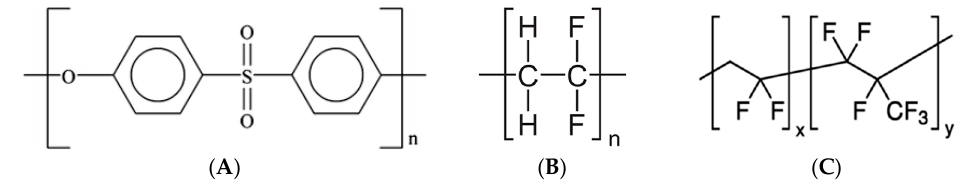
Figure 1. The structure of ( A ) Poly(ethersulfone) (PES), ( B ) Poly(vinlidine fluoride) (PVDF), and ( C ) Poly(vinlidine fluoride-co-hexafluoropropylene) (PcH) polymers.